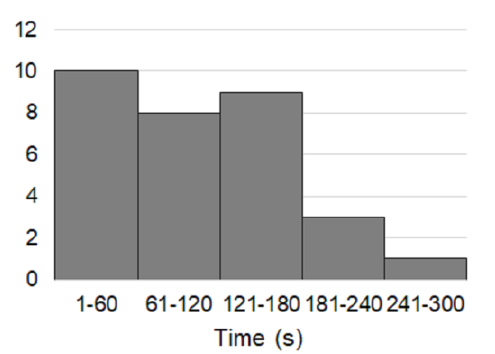
Figure 2. Histogram of TeaPick TM app use time. Table 2. Usability of TeaPick TM .